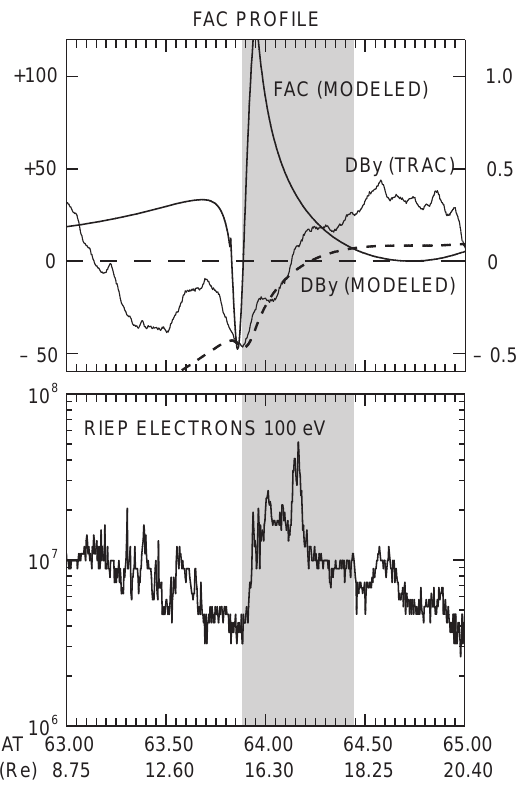
Fig. 8. Modelled field-aligned current (FAC) latitudinal profile ( bold line ) and equivalent DB magnetic field perturbation ( dashed line ) at y ionospheric altitudes, compared to measured D B y variations (nT) of the horizontal magnetic field (running averages on 1.2 s.). The electron flux latitudinal profile at 100 eV (RIEP spectrometer) is given for comparison in the bottom panel and demonstrate that the upward FAC between ILAT = 63.9 and 64.45 ( shaded area ) coincides with enhanced fluxes of low-energy £ 1 keV electrons (the weak arc). X ( R ) E is the projected X distance in